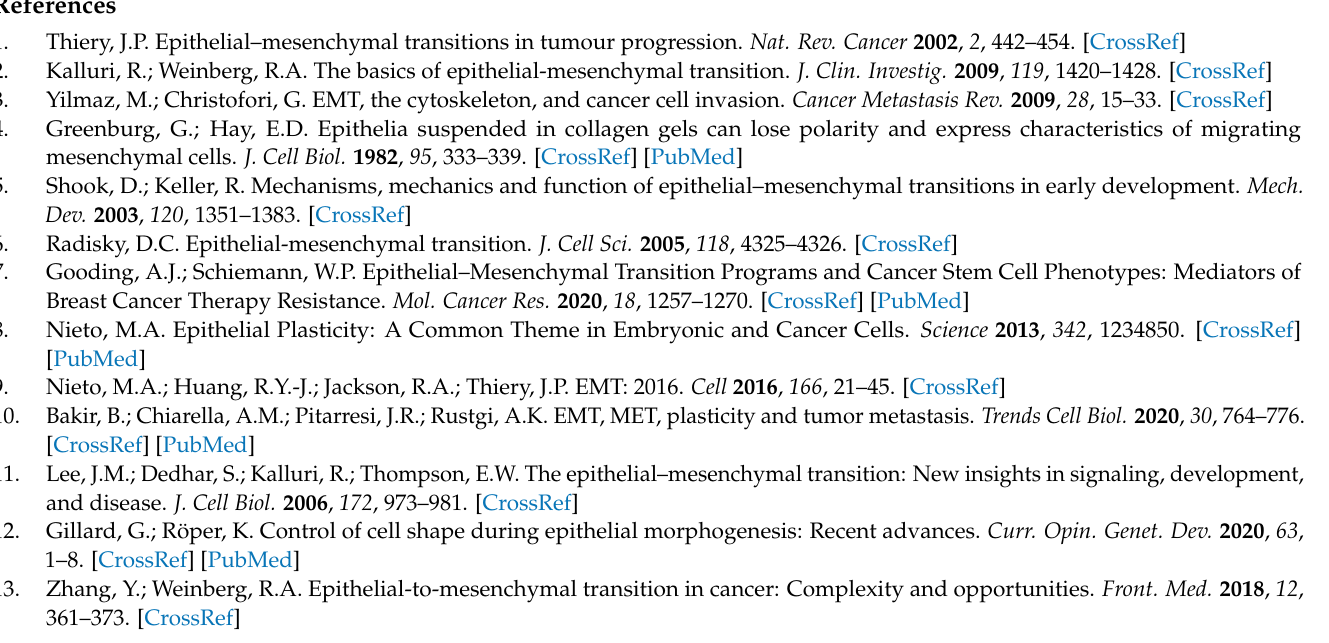
cancerous tissues. Figure S2. RKIP vs. VIM across normal and cancerous tissues. Figure S3. RKIP vs. CDH2 across normal and cancerous tissues. Figure S4. RKIP vs. CDH1 across normal and cancerous tissues. Figure S5. RKIP vs. EPCAM across normal and cancerous tissues. Figure S6. RKIP vs. LAMA1 across normal and cancerous tissues. Figure S7. RKIP vs. LAMB1 across normal and cancerous